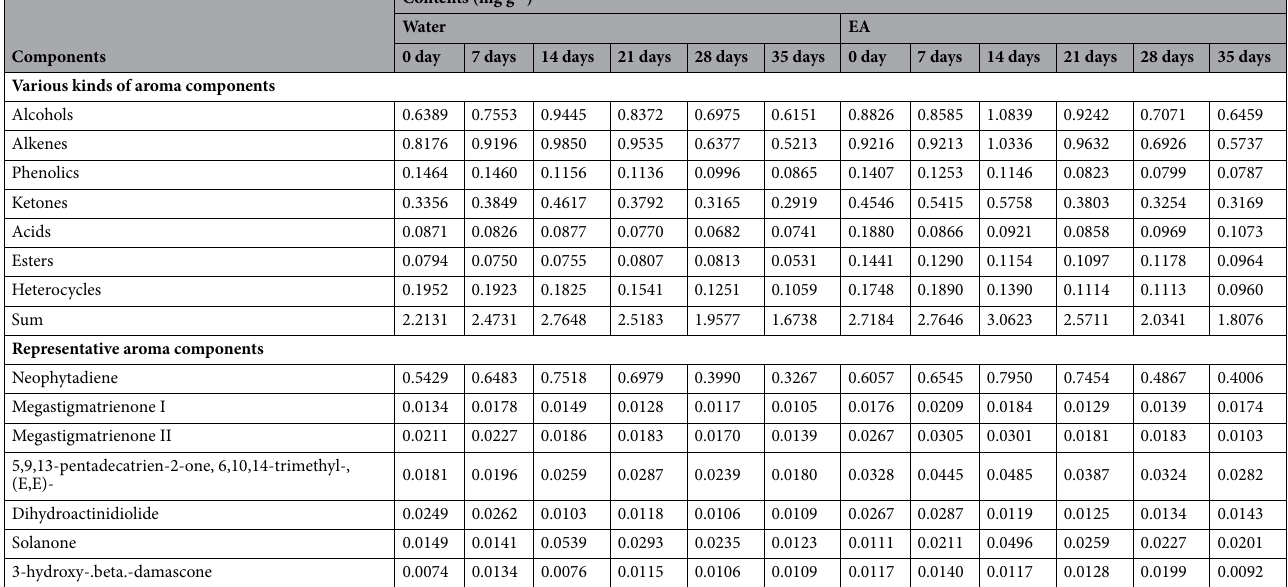
Table 2. Contents of aroma components of CTL samples in water- and